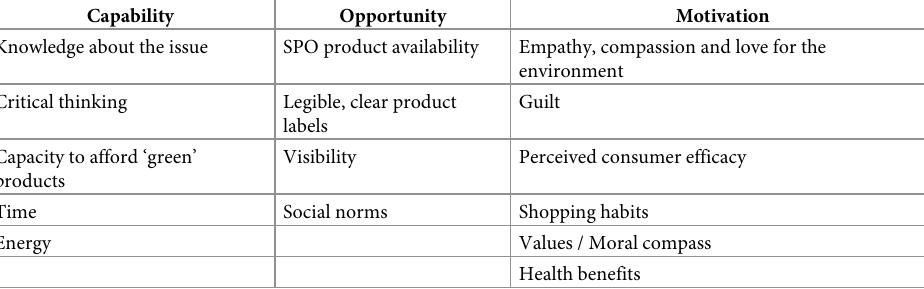
Table 1. COM-B factors influencing the purchase of